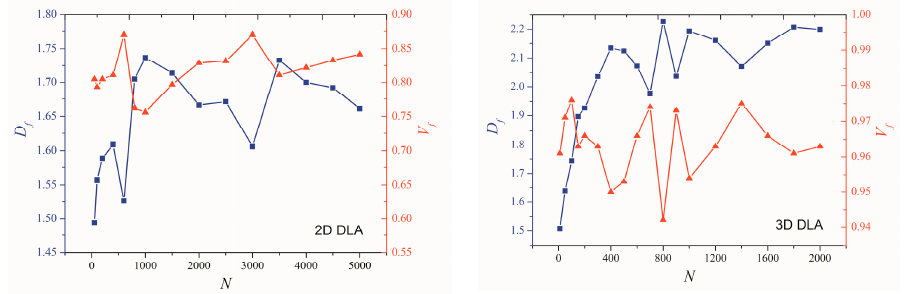
Figure 4. Effect of particle number on the fractal dimension and porosity of 2D and 3D DLA aggregates.